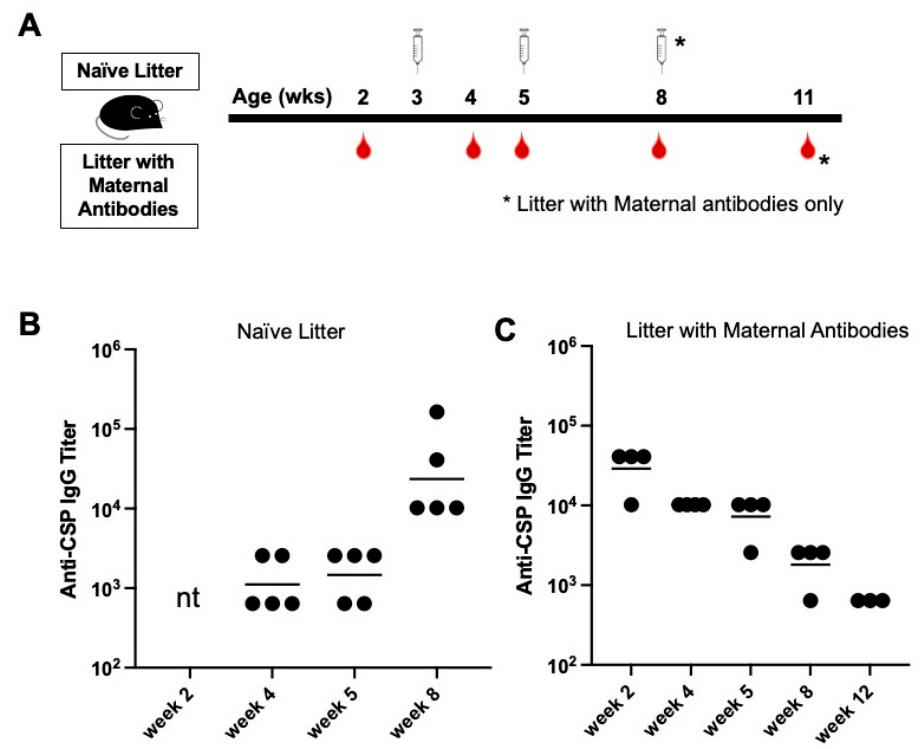
Figure 2. Comparison of antibody responses to CIS43 VLP immunization in mice with and without maternal antibodies. ( A ) Experimental set-up. Mice from a naïve litter and from a litter with maternal antibodies were immunized intramuscularly with 5 µ g of CIS43 VLPs at the indicated ages. Sera were collected at the indicated timepoints. ( B ) Anti-CSP IgG endpoint titers in naïve pups (from unimmunized dams) at 4, 5, and 8 weeks of age. ( C ) Anti-CSP IgG endpoint titers in pups from CIS43 VLP-immunized dams at 2, 4, 5, 8, and 12 weeks of age. Each data point represents an individual mouse and lines denote the geometric mean titer of each group. nt, not tested.